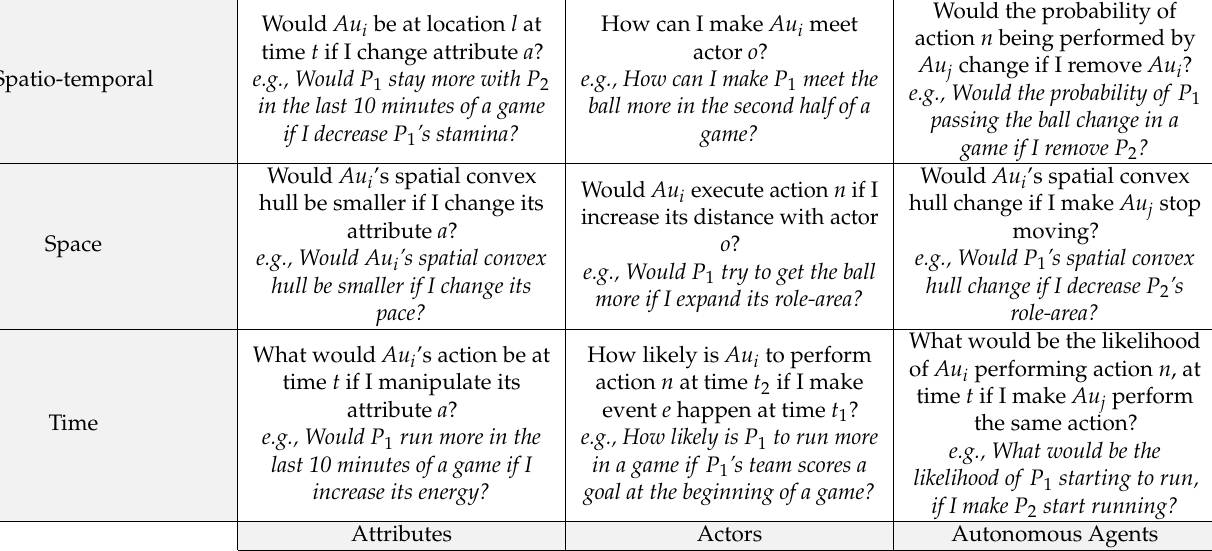
Table 2. Some typical intervention and how questions that a doer can potentially answer about the auto-agents Au i and Au j (players P 1 and P 2